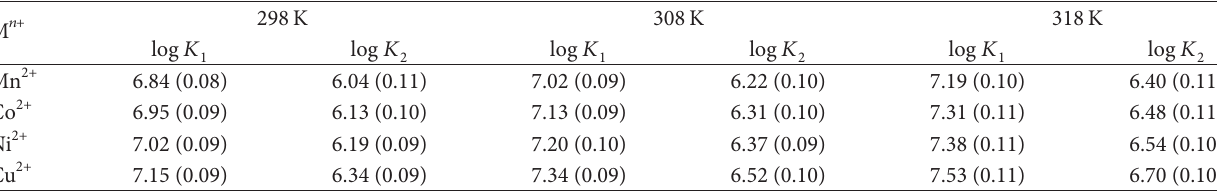
complexes of ligand (L 2